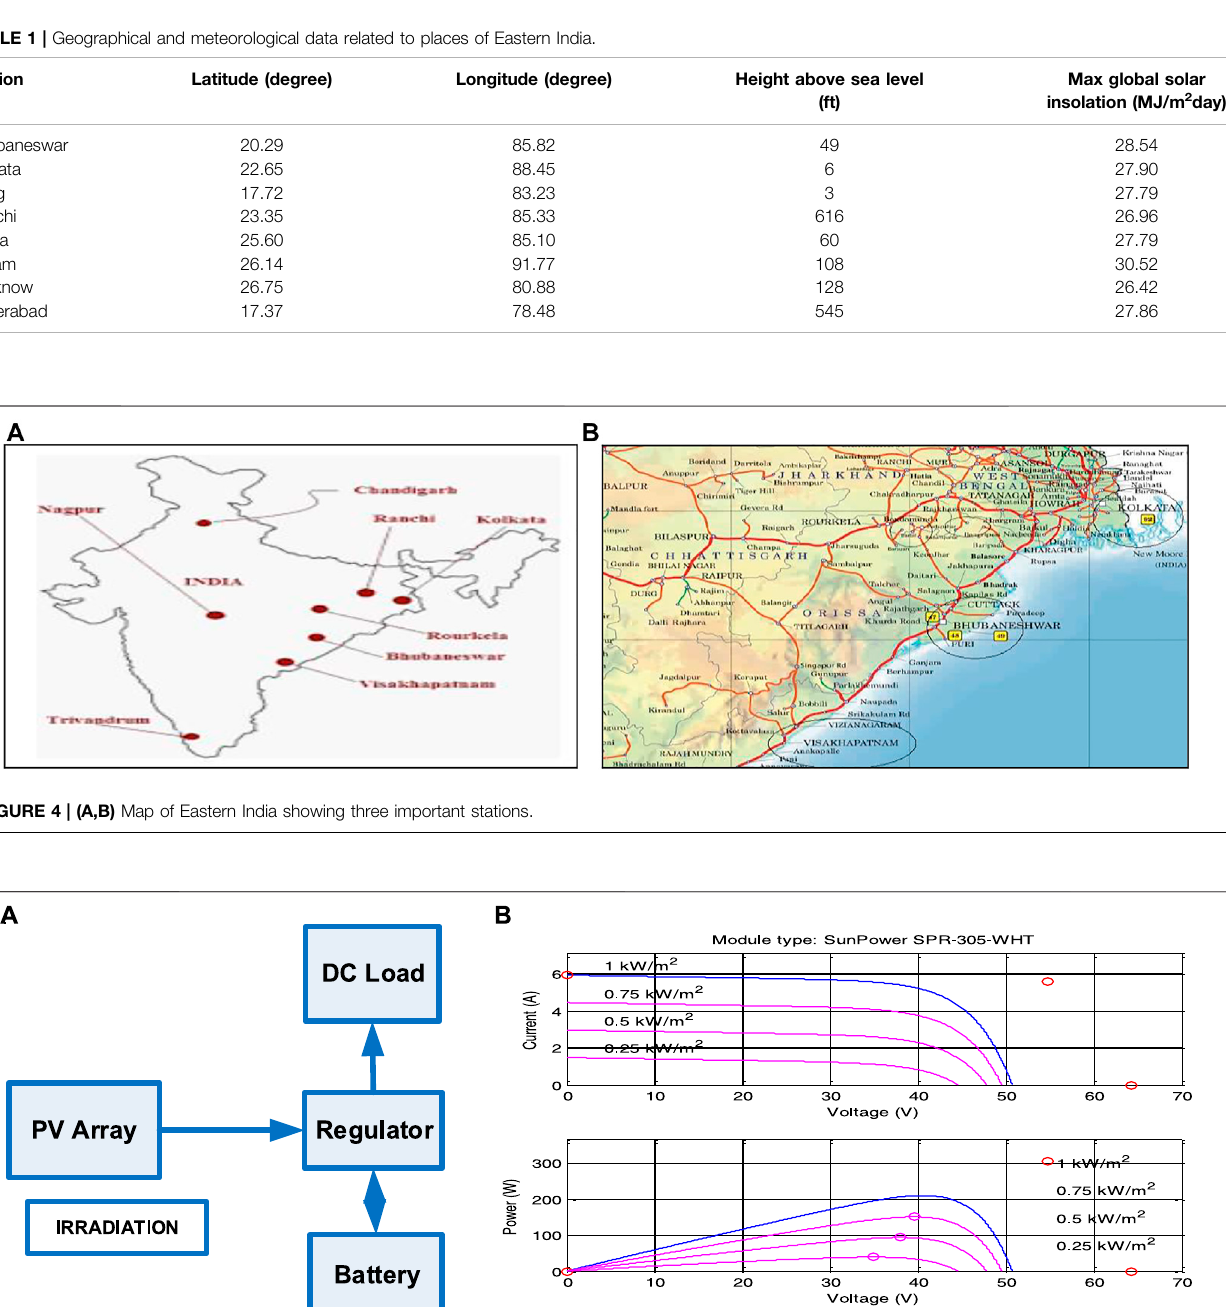
Frontiers in Energy Research |